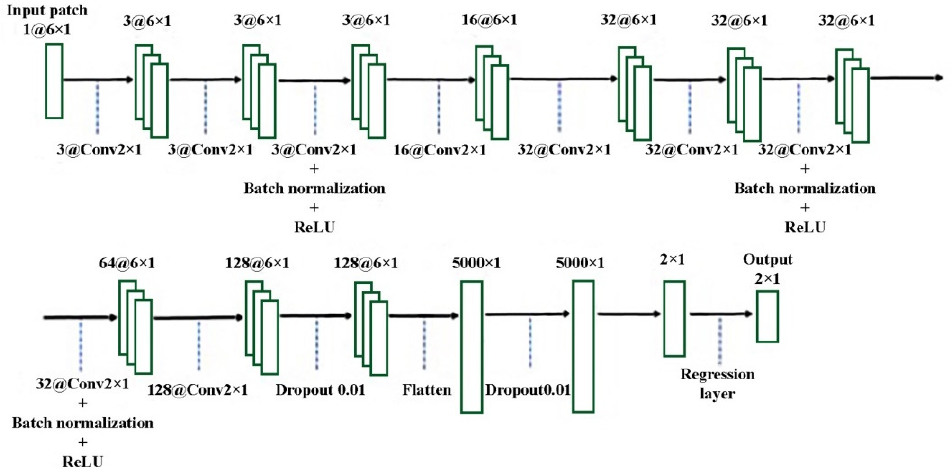
Figure 6. CNN model implemented in the RECPOID model [3].